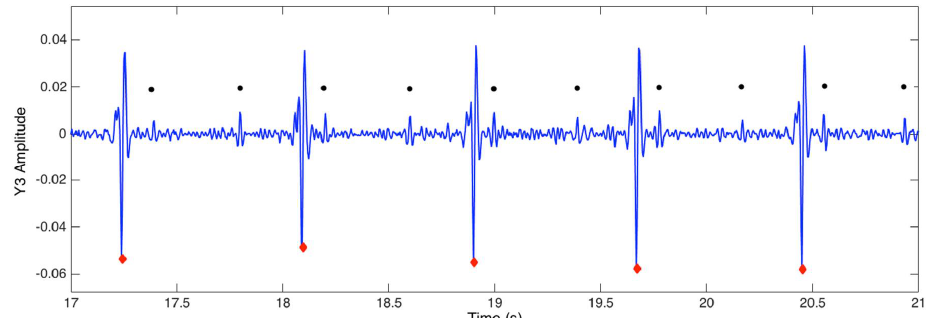
Figure 5. Maternal and Fetal ECG after the pre-processing phase ( Y j = X 50 FILj − X MAj , j = 3 ) , in which MQRSs (red diamonds) and FQRS (black dots) are recognized and stored as t ( k ) and tf j ( k ), respectively.